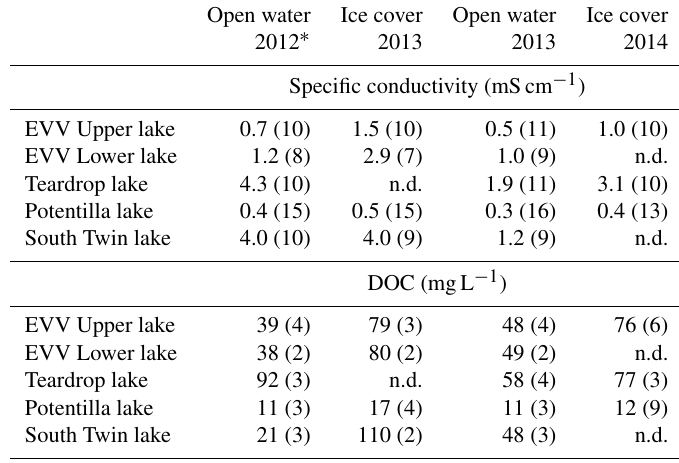
Table 2. Seasonal and annual variation in median specific conductivity and DOC.